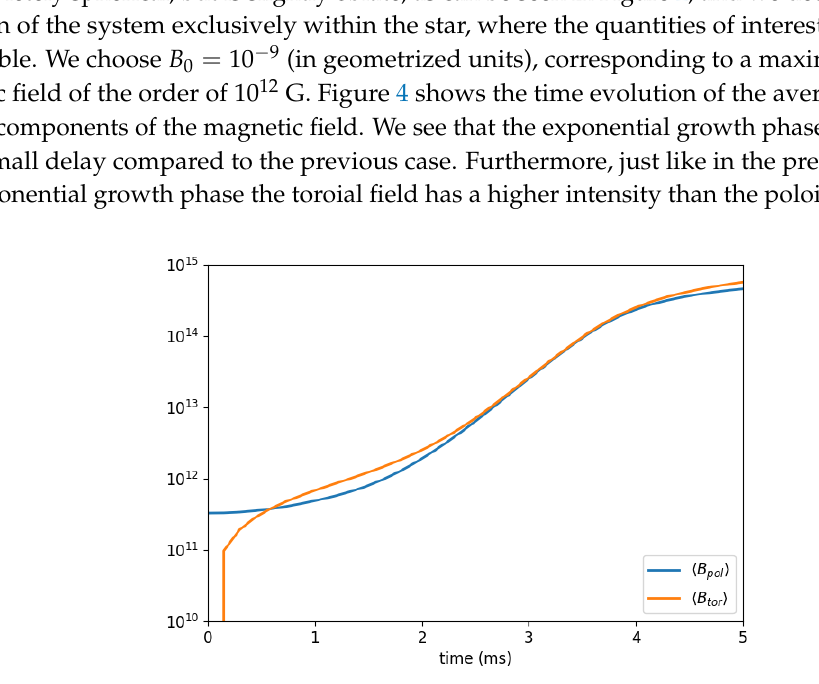
Figure 4. Time evolution in the Run1 for the average value of poloidal ( B pol ) and toroidal ( B tor ) components of the magnetic field in the first 5 ms in the case of a purely dipolar initial magnetic field. Values in Gauss (G) along the vertical axis.